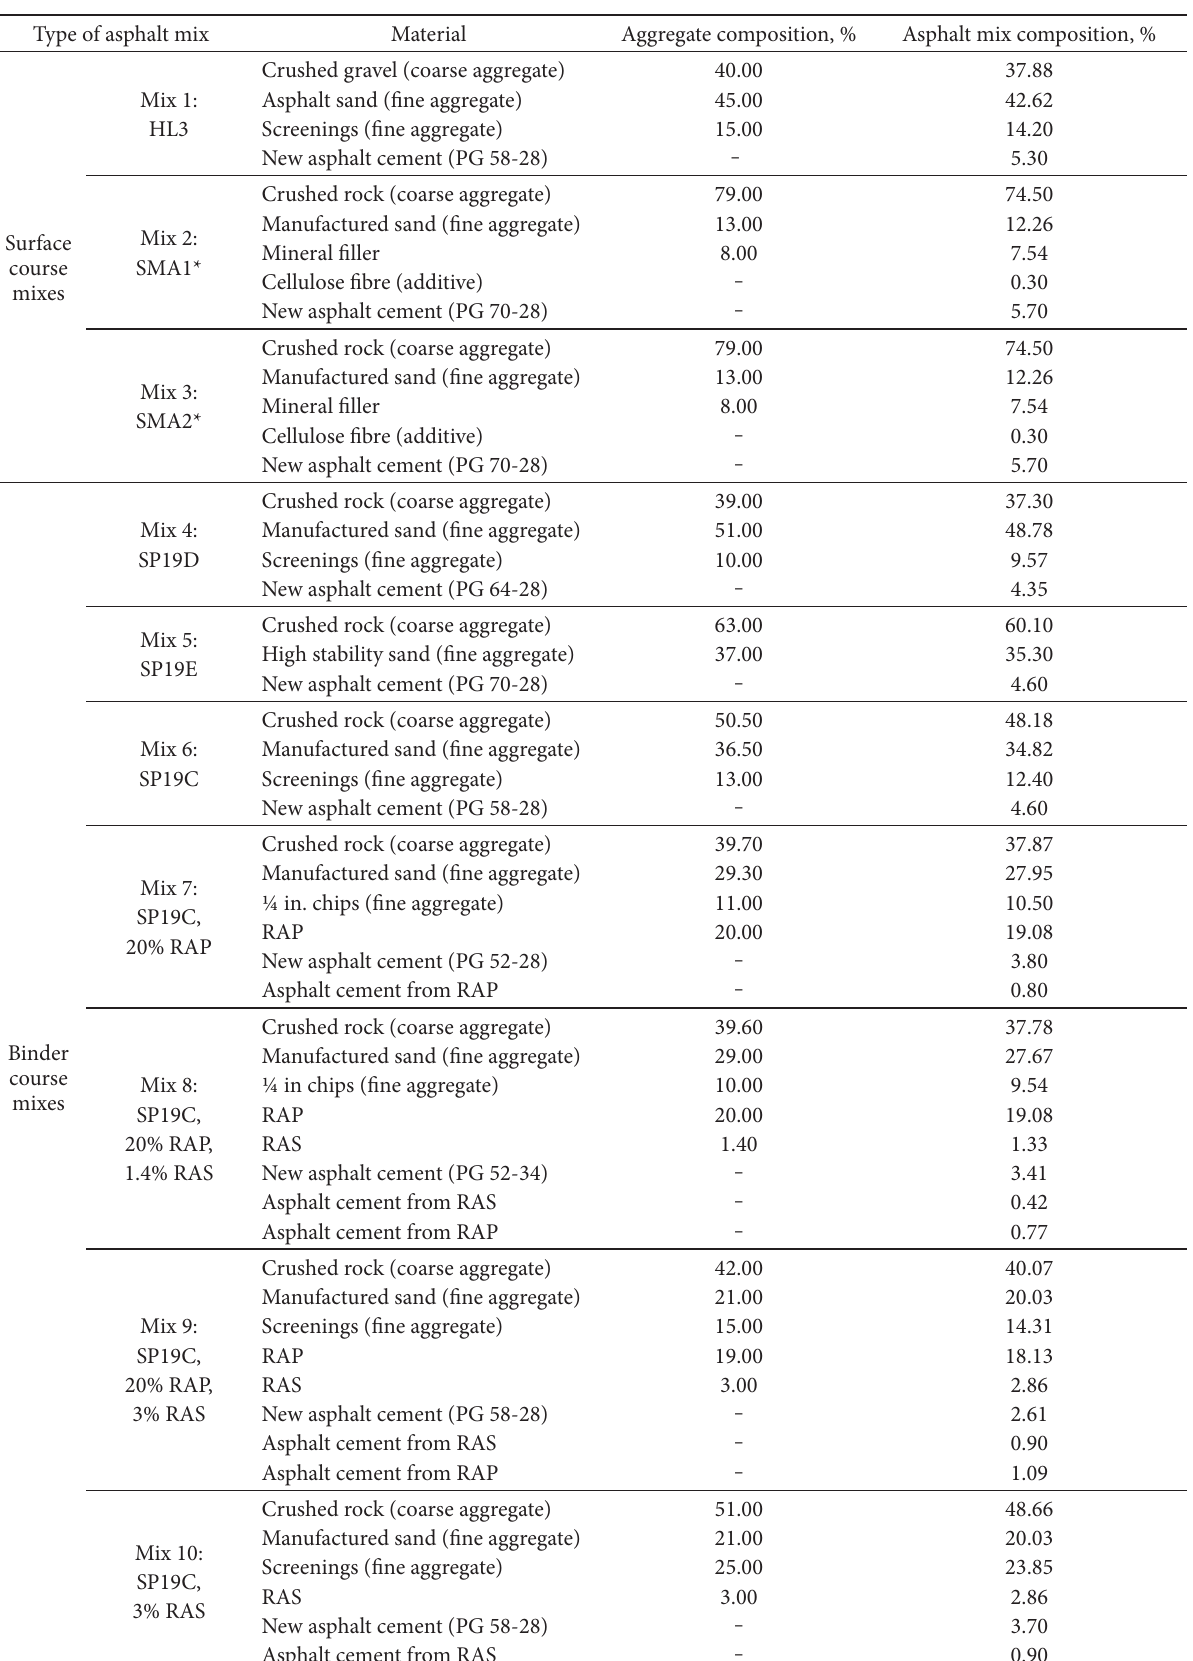
Table 1. Constituent materials and composition of different HMA mixes Type of asphalt